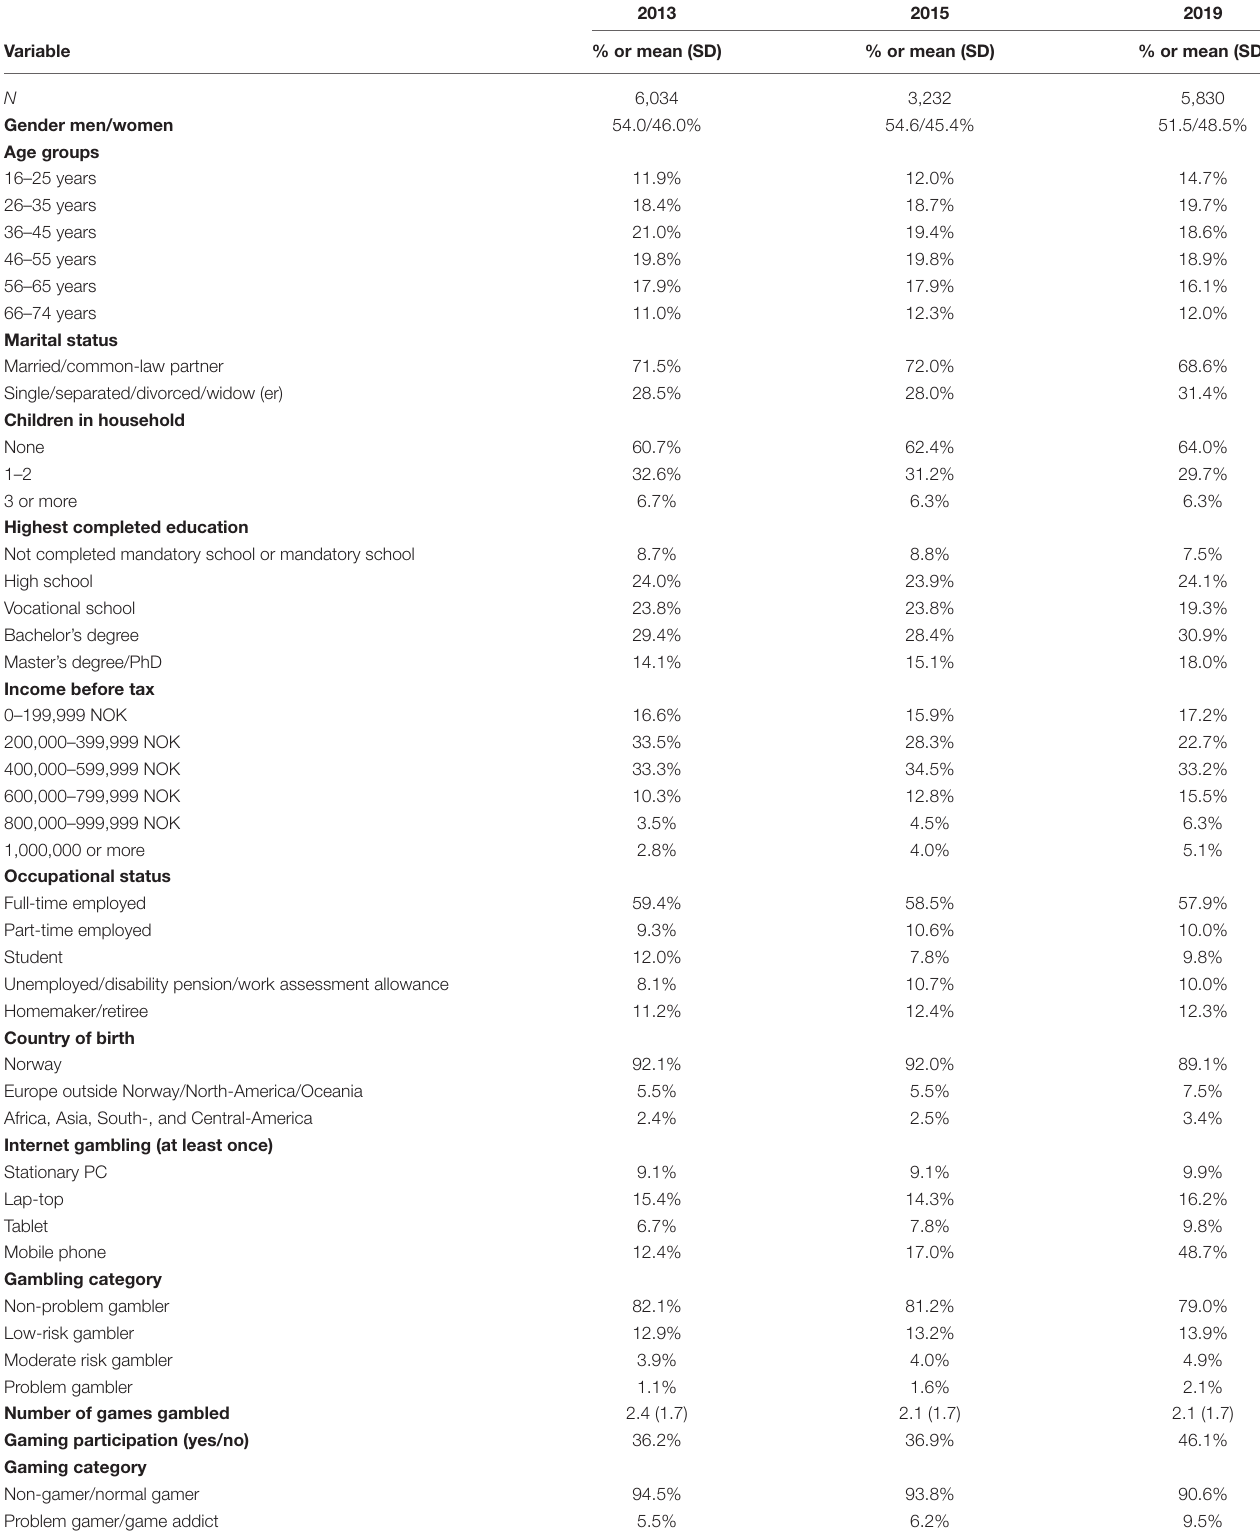
TABLE 1 | Descriptive statistics of study variables in the three (2013, 2015, and 2019) surveys among